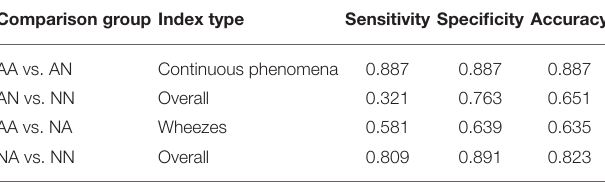
TABLE 5 | Classification results for all comparisons and best index in each group. Comparison group Index